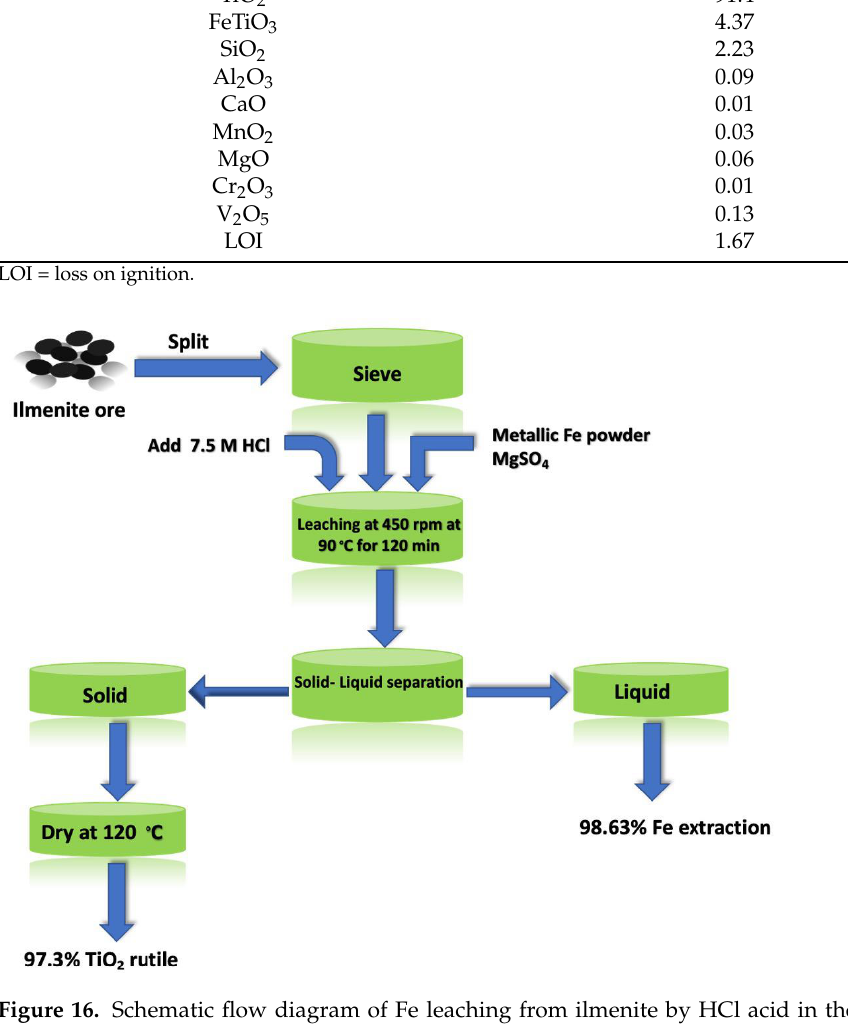
Figure 16. Schematic flow diagram of Fe leaching from ilmenite by HCl acid in the presence of me- tallic Fe and MgSO 4